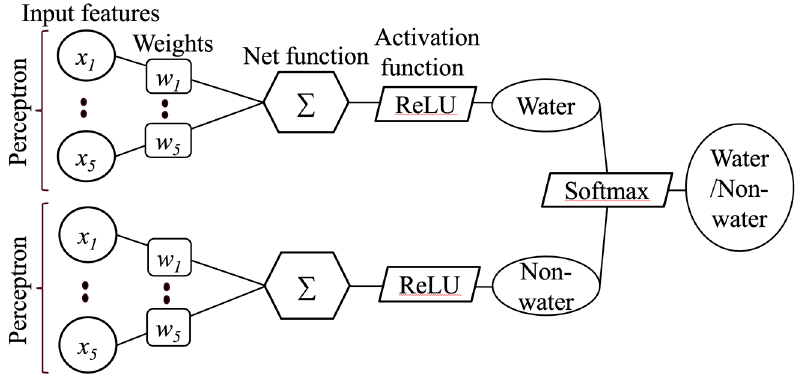
Figure 2. Perceptron neural network with two perceptrons: one for water region and another for non-water region.